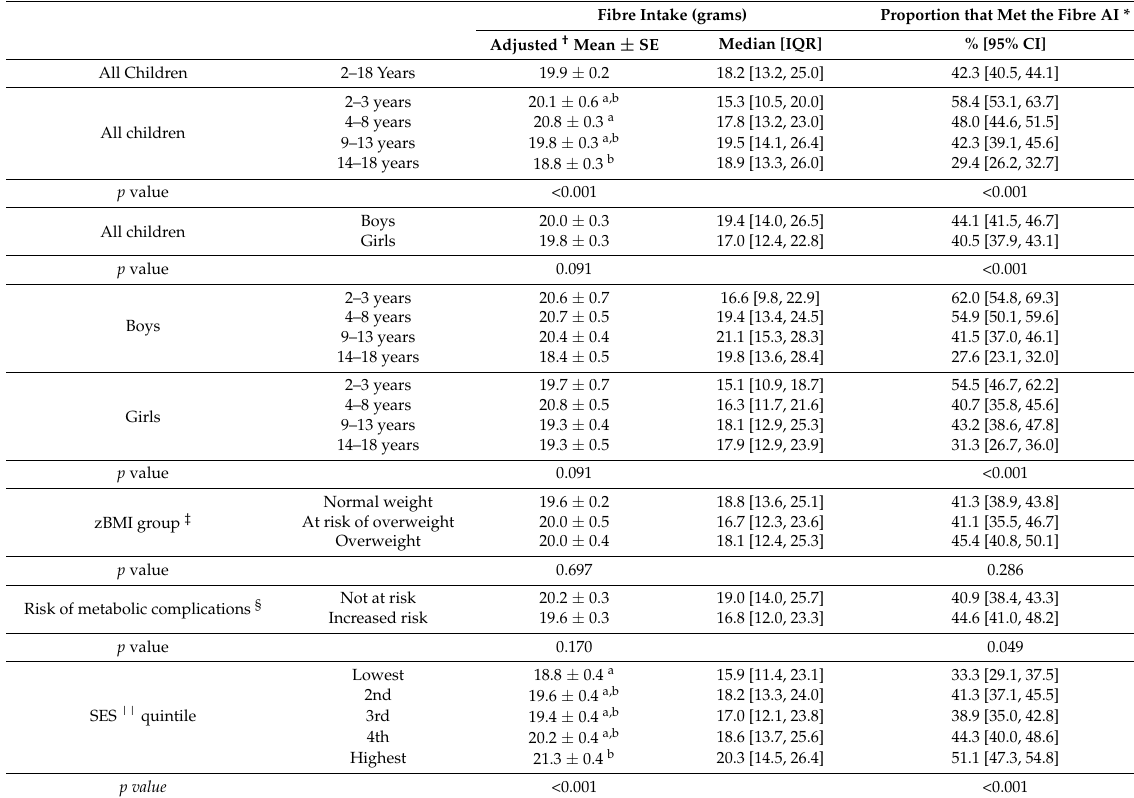
Table 1. Total daily fibre intake and the proportion of children aged 2–18 years that met the fibre AI by age, sex, SES, and anthropometric